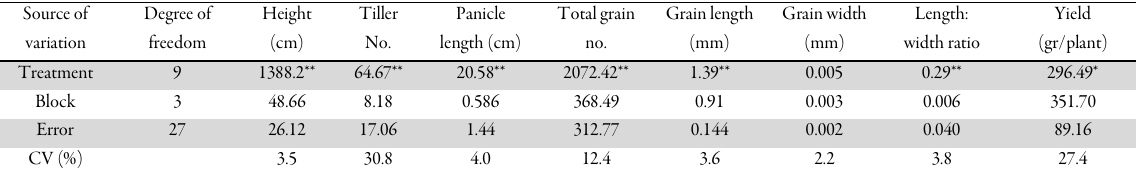
Table 2. Analysis of variance for studied traits Source of variation